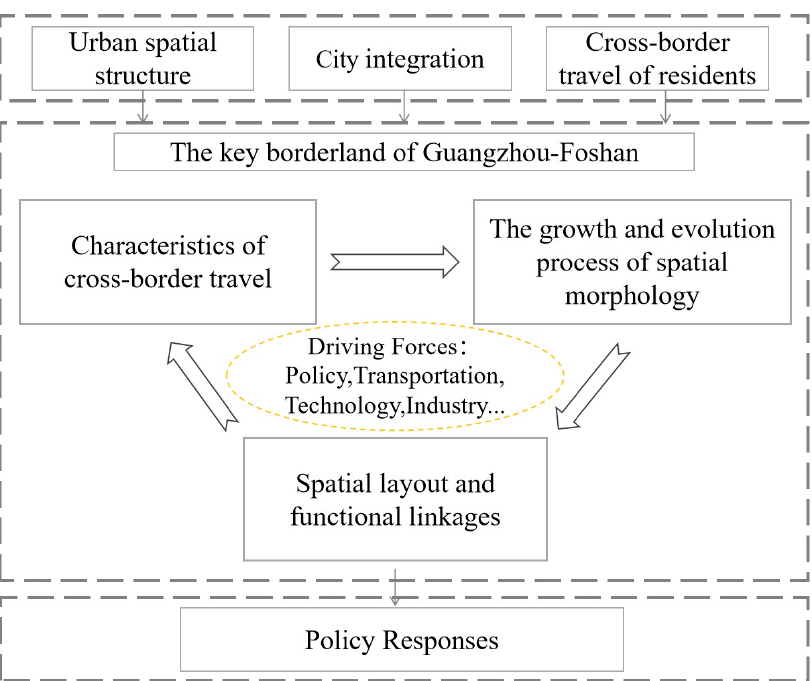
Figure 2. The analytical framework of this study.